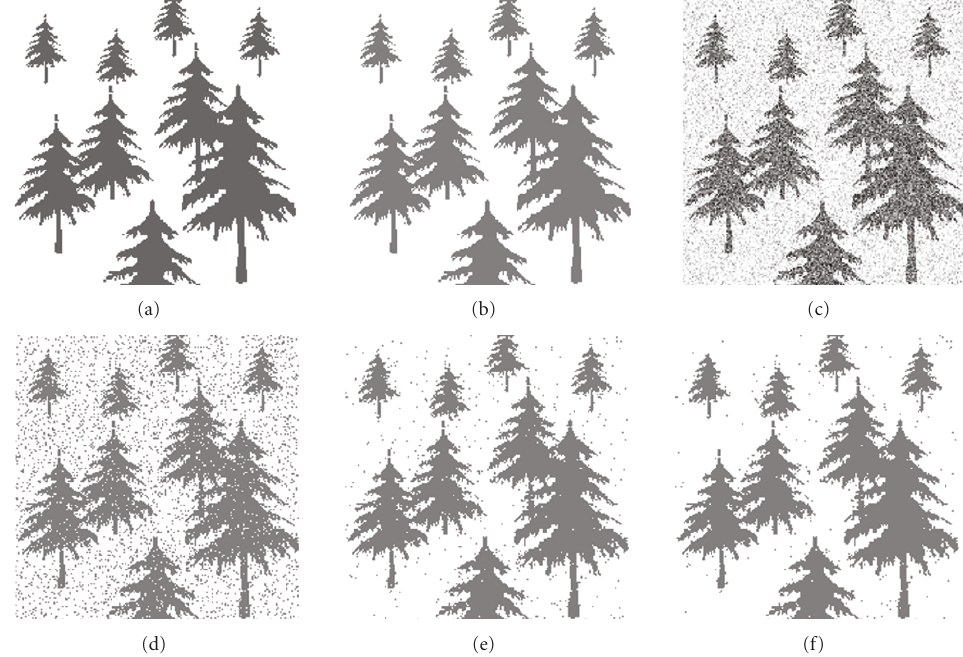
Figure 1: Segmentation result of the algorithm for a typical image of synthetic dataset: (a) original image, (b) modified image with medium level of contrast, (c) noisy image of (b) with high additive and multiplicative noise, (d) FCM result, (e) and (f) direct-MC and indirect-MC with automatic seed selection results,